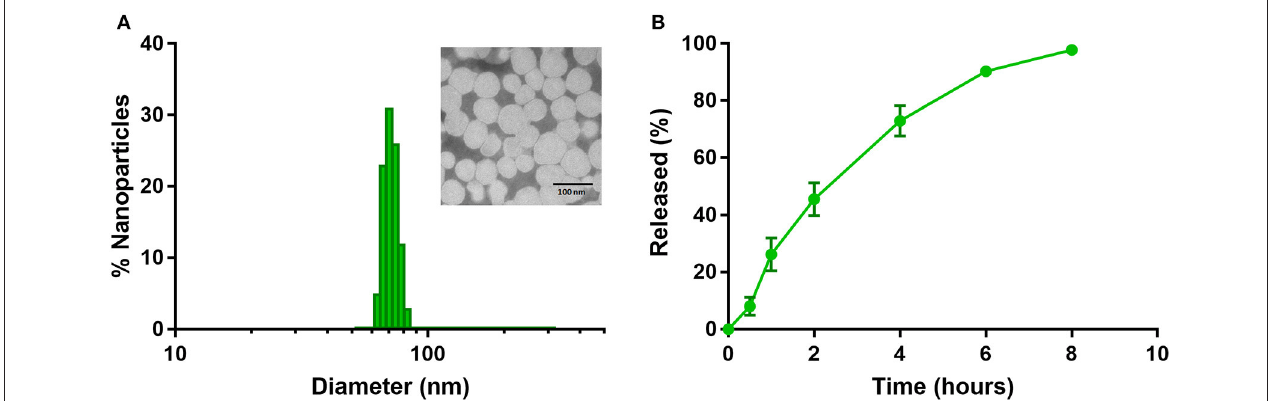
FIGURE 1 | (A) Physicochemical characterization of NanoTalazoparib measured by dynamic light scattering and (inset) transmission electron microscopy after staining with 1.5% phosphotungstic acid. (B) Drug release kinetics of Talazoparib from nanoparticles at 37 ◦ C under constant agitation.